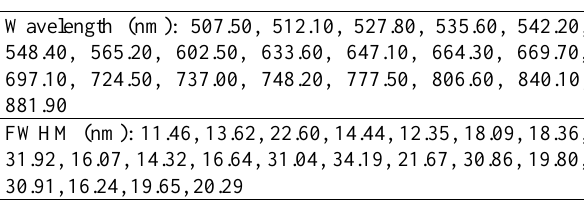
Figure 5. SNR of the spectral image data collected from a) manned platform using a spectral filter of 500-900 nm b) UAV with 500-900 and 600-750 nm